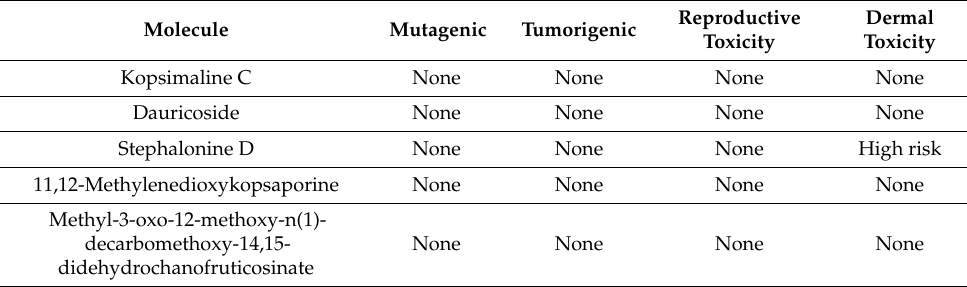
Table 6. Toxicity analyses of the selected